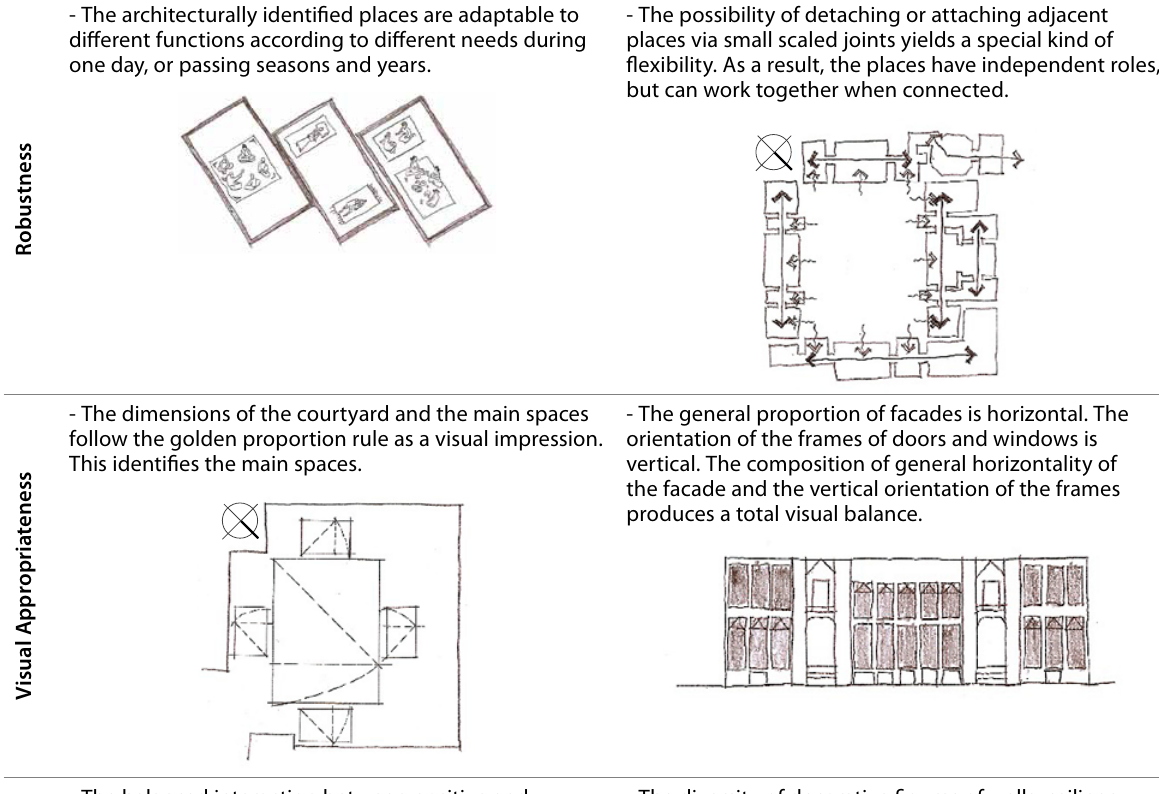
- The balanced interaction between positive and negative masses in horizontal plan (i.e., the interaction of building mass and courtyard) and in every individual façade (i.e., the interaction of opaque parts (walls) and transparent parts (windows/doors( of facade) produces visual balance.